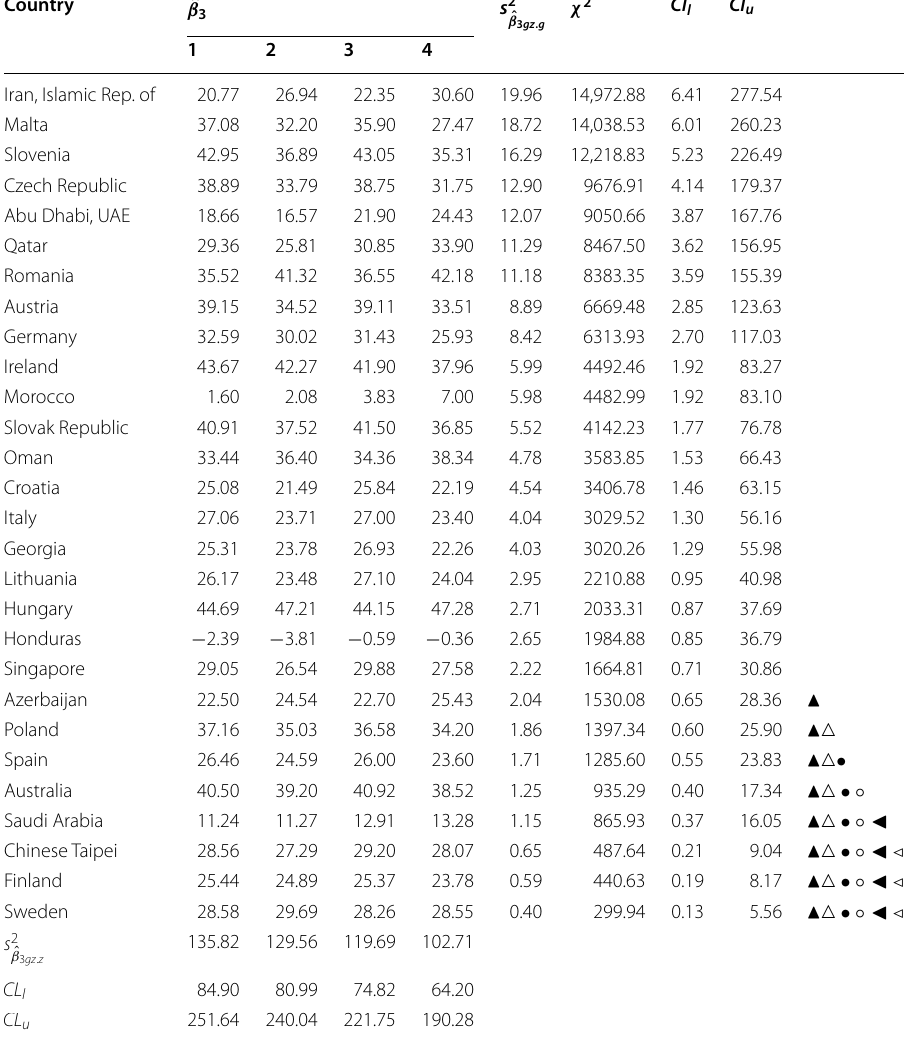
Table 8 Distribution of ˆ β 3 across scaling models and countries, χ 2 -value and asymmetric confidence interval ( CI l lower bound, CI u upper bound; countries ordered in descending order of the conditional variance of ˆ β 3 across scaling models given country g